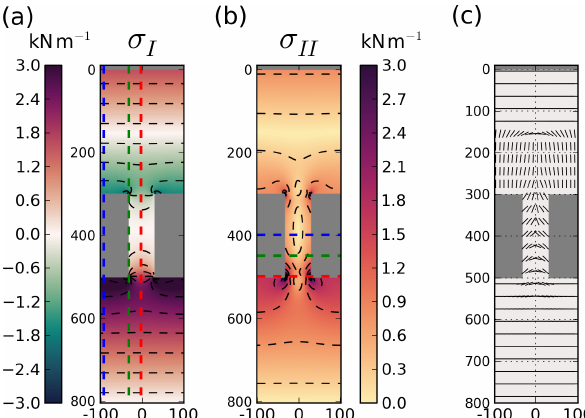
Figure 7. Stress fields in landfast ice during Phase A. (a) Normal stress invariant ( σ I ) with colored dashed lines to indicate the ver- tical transects used in Fig. 8, (b) shear stress invariant ( σ II ) with colored lines to indicate the horizontal transects used in Fig. 8 and the (c) orientation of the second principal stress component.